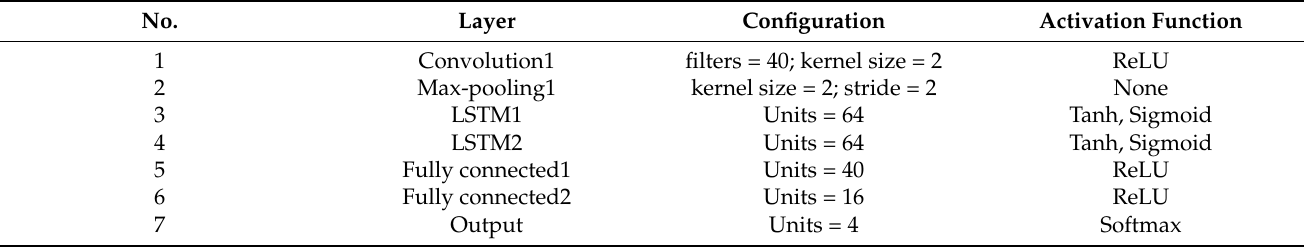
Table A1. Layer configuration of the 1DCNN-LSTM model (time step = 3 s, data sets = head + eye).